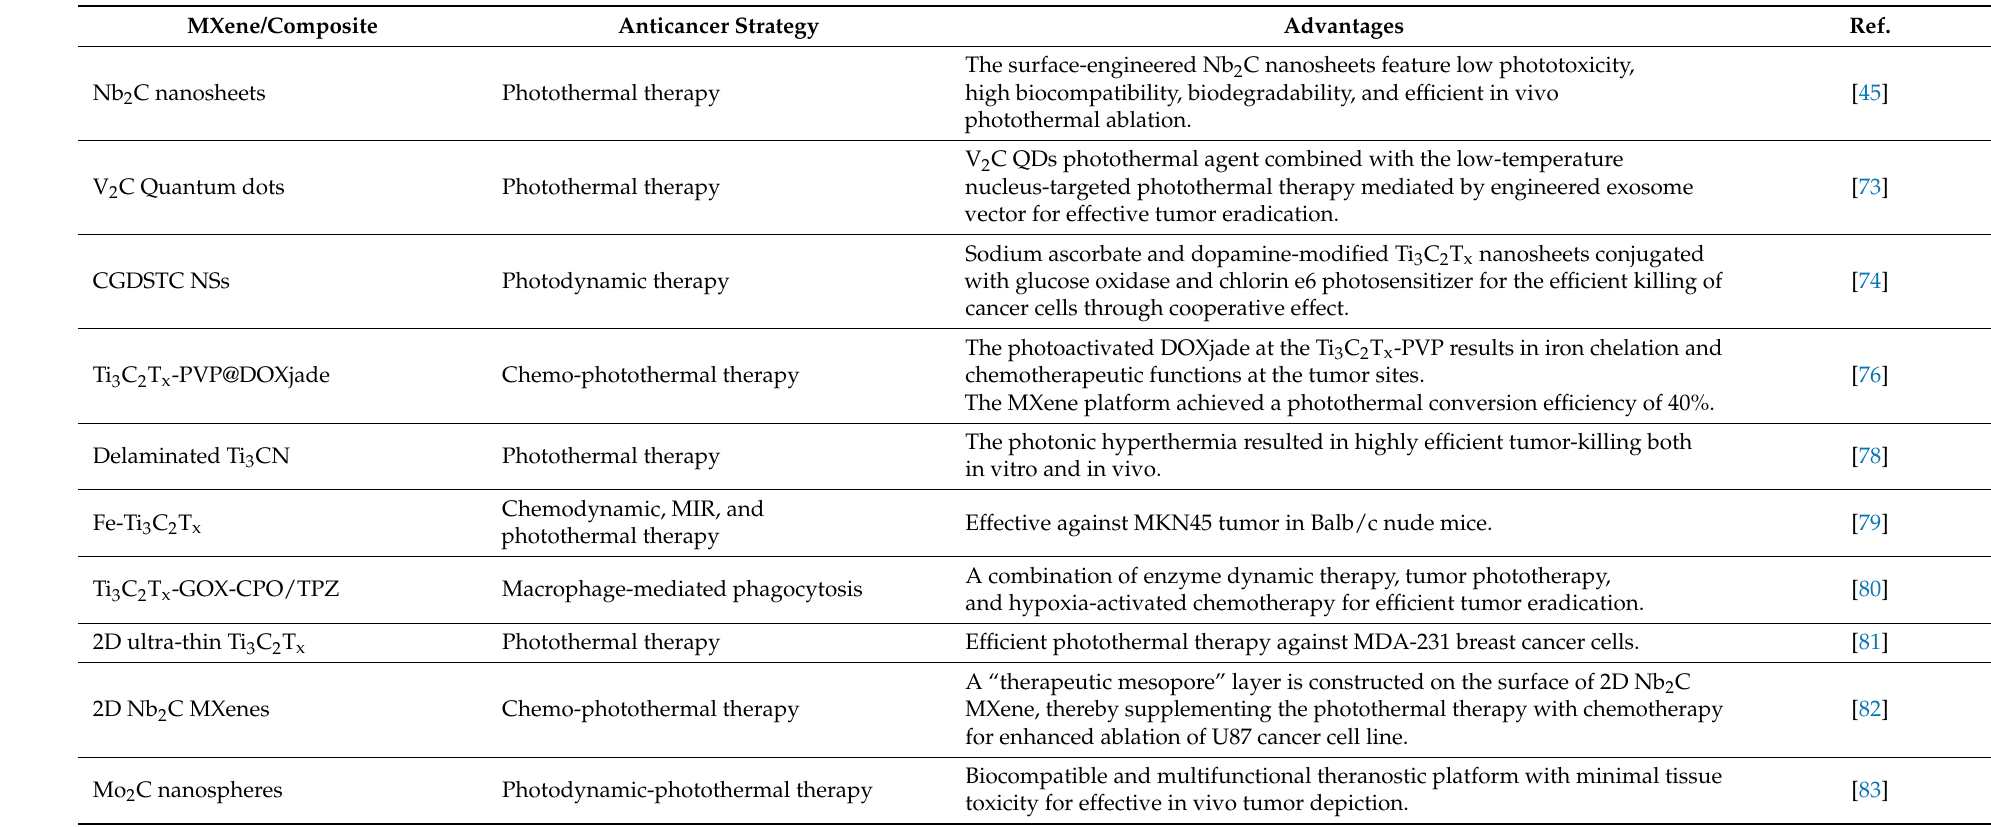
Table 2. Literature reports on the anticancer applications of MXenes and